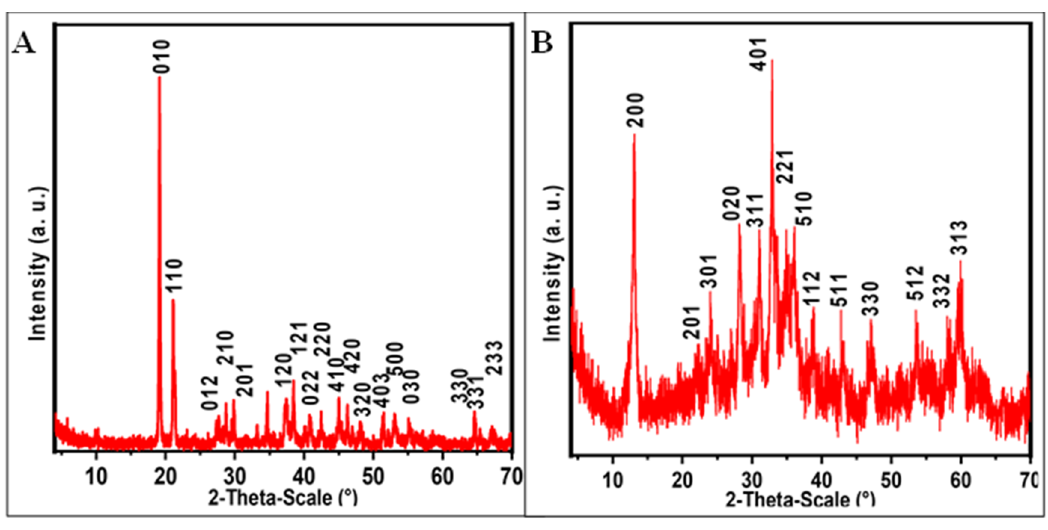
Fig. 1. XRD patterns of aluminum [A] and zinc [B] sludges.